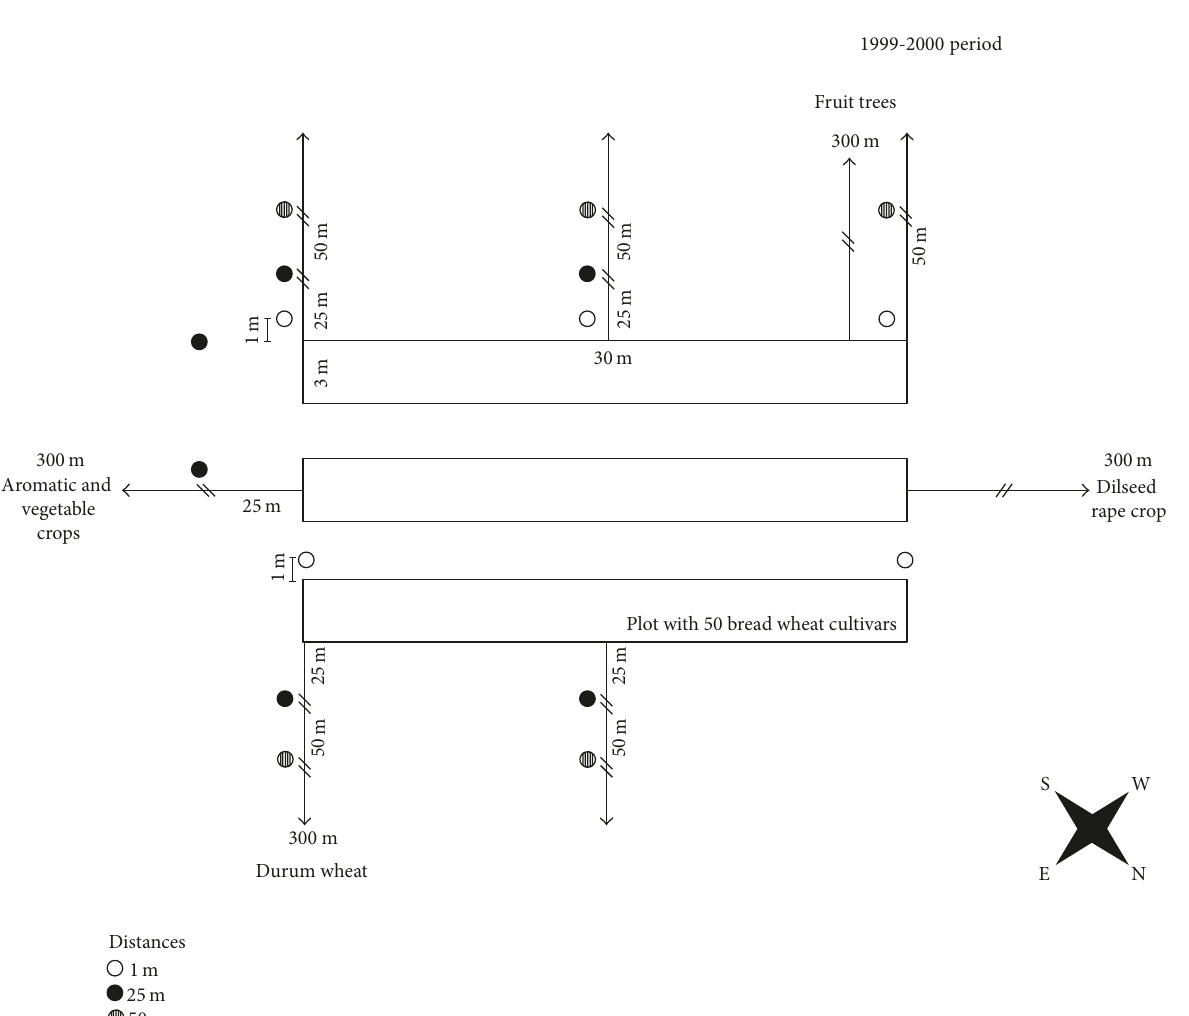
Figure 2: Spatial diagram of the traps arrangement: 1999-2000